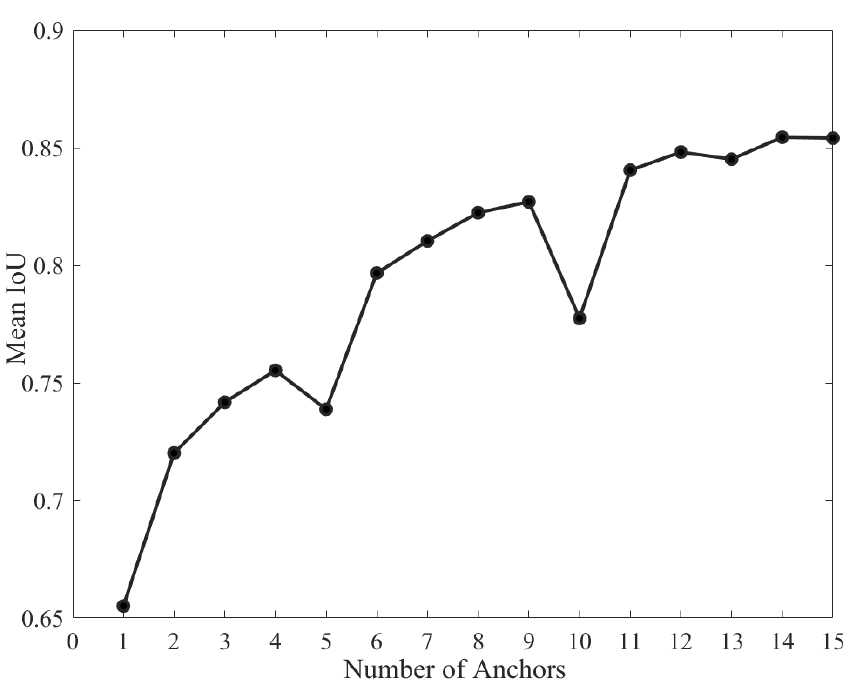
Figure 5. Mean IoU versus number of anchors: determination of the number of anchor boxes using a sunflower test sequence by analyzing the evaluation metric mean